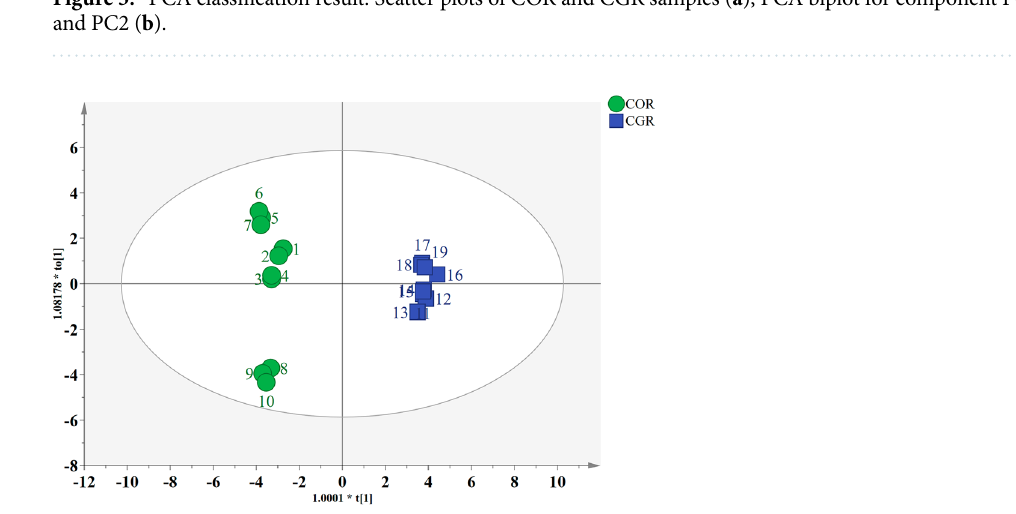
Figure 6. OPLS-DA classification result. Score plots showing the classification of authentic COR and counterfeit CGR